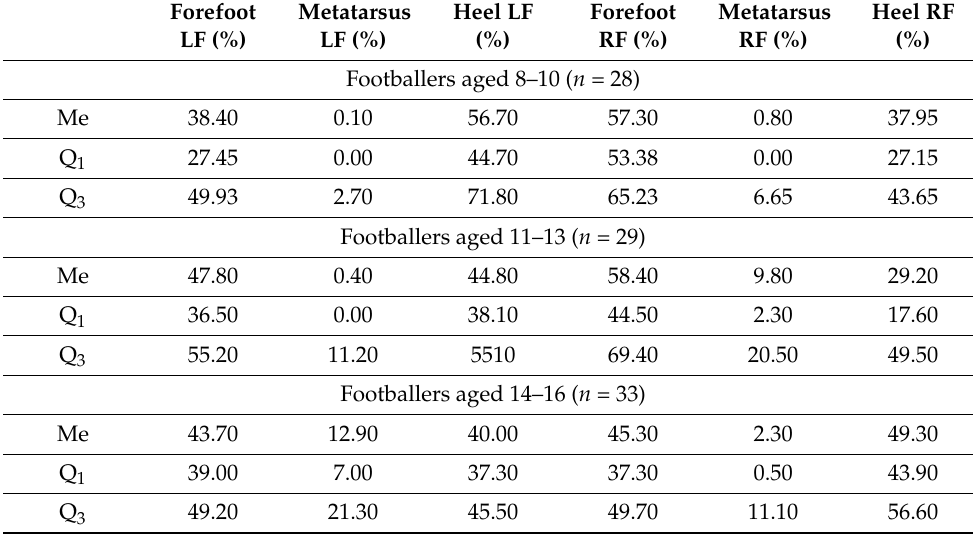
Table 1. Characteristics of the distribution of pressure forces of the foot in the age groups of the studied boys.